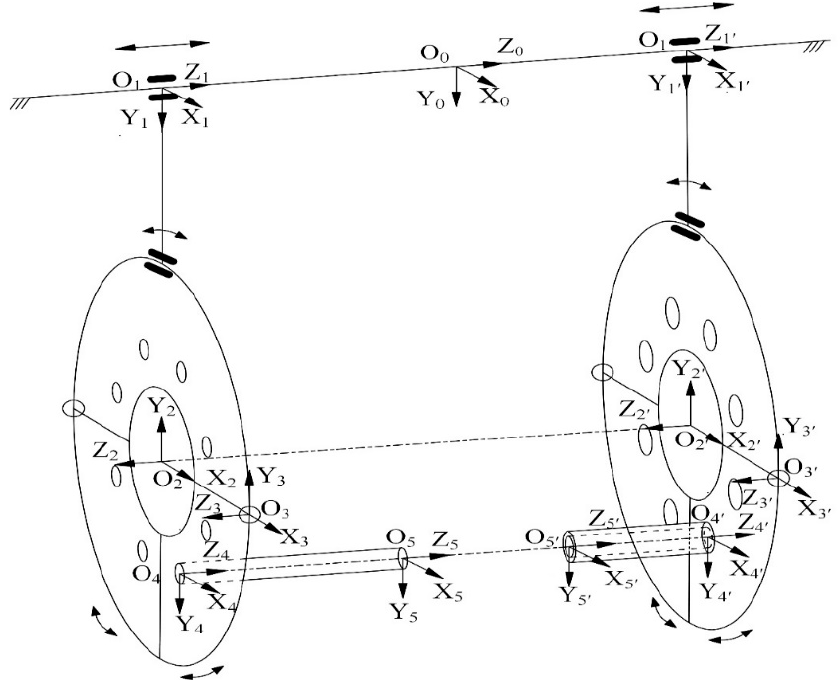
Figure 4. The coordinate system of deep-water bolt flange automatic connection tool.